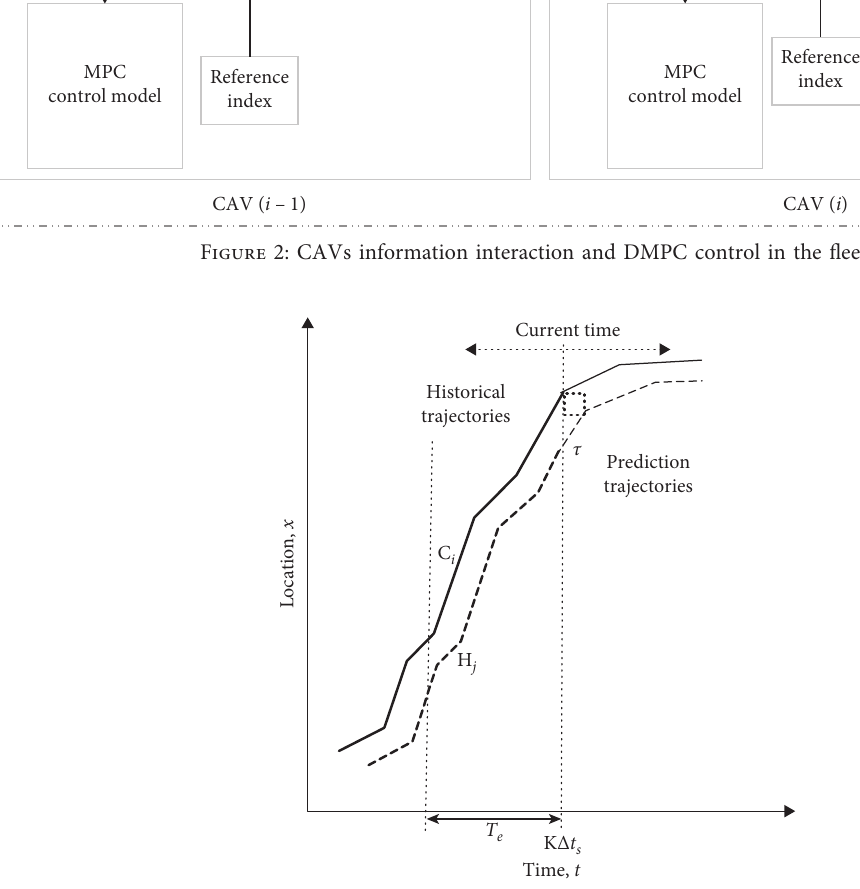
Figure 3: Spatial-temporal delay matching curve for HDV in